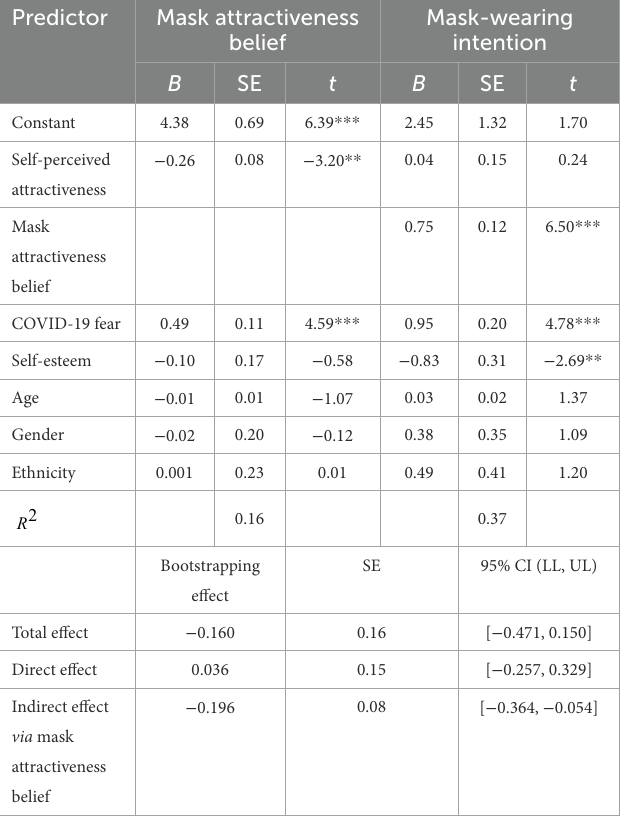
TABLE 1 Regression results for simple mediation in Study